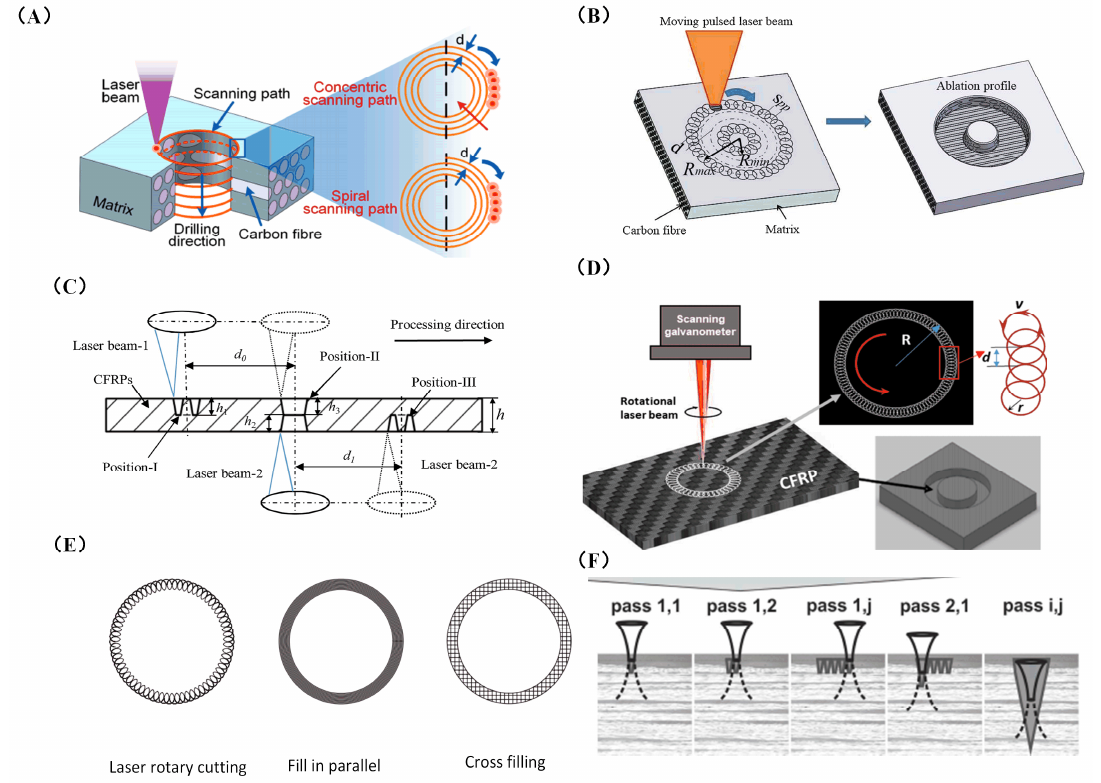
Figure 12. Various scanning techniques to improve quality and efficiency in laser processing: ( A ) schematic showing two distinct scanning pathways and the laser-drilling procedure [82]; ( B ) pulsed-laser coaxial-trepan drilling technique illustrated schematically [84]; ( C ) schematic diagram of dual-beam opposite dislocation (DBOD) laser-drilling process [84]; ( D ) the picosecond laser “double rotation” cutting method [87]; ( E ) schematic diagram of scanning mode [88]; ( F ) the approaches used in the experiments to define the maximum possible cuing depth [89].